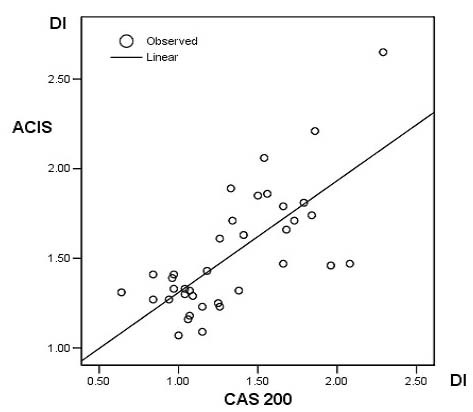
Linear regression analysis of DI values determined on the CAS 200 and ACIS instruments (n = 37). Note the excellent correlation obtained by the two systems. R = 0.89, p < 0.01 (two tailed).